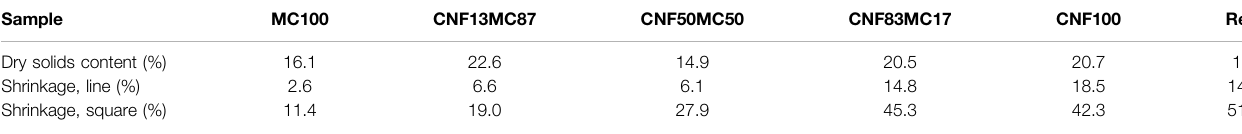
TABLE 3 | Dry solids content and shrinkage of samples with increasing CNF content *) Reference sample, CNF hydrogel.